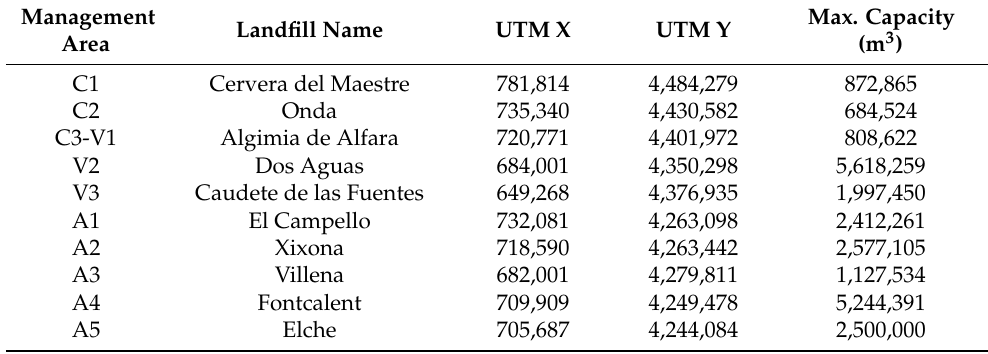
Table 2. Main characteristics of the 10 sanitary landfills currently in operation inside Valencia